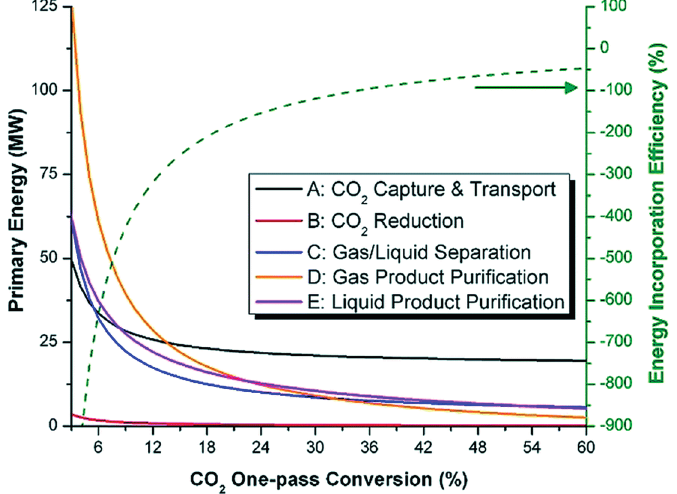
Figure 31. Dominance of CO 2 capture stage on primary energy costs in photocatalytic CH 3 OH synthesis from CO 2 /H 2 O (reproduced from [232] with permission of the Royal Society of Chemistry).